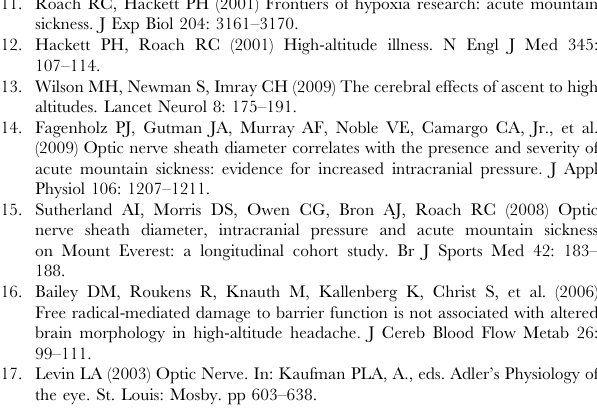
Table S1 Overview of HRT3 H readings between BL1 and